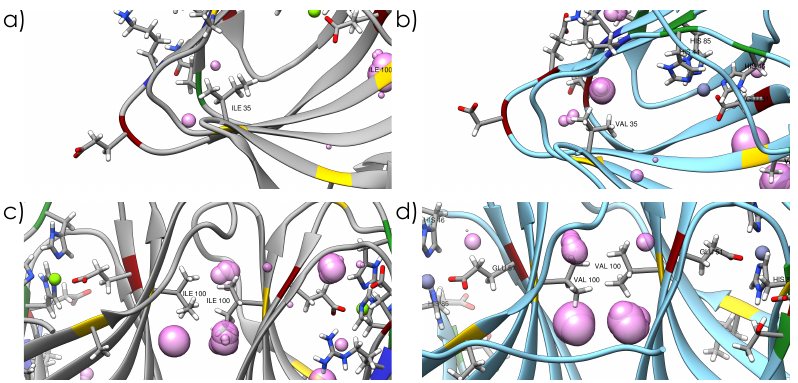
Figure 1. Crystal structures of Tba PMI ( a ) and Tko PMI ( b ) with labelled substituted residues for comparison. Residues are color-coded for polarity (red for acidic, blue for basic, green for polar, and yellow for hydrophobic), and the active site is also shown (details in Figure S7).